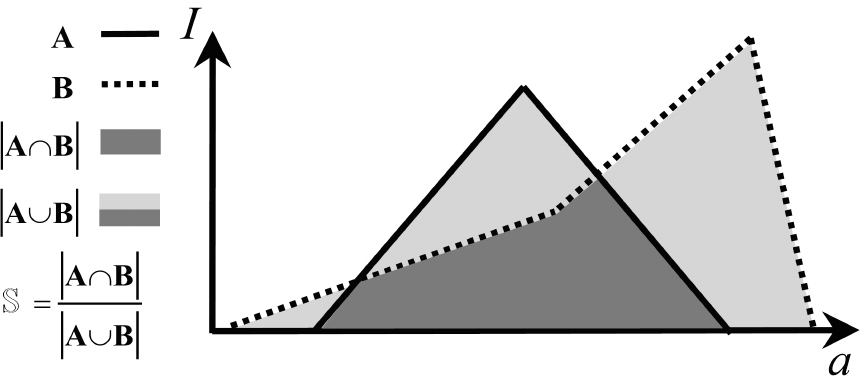
Figure 9. A visual representation of the similarity between two